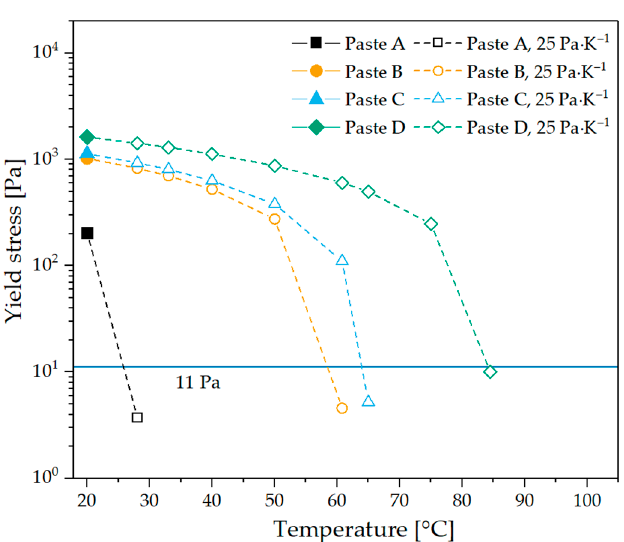
Figure A1. Yield stress versus temperature for pastes A–D. Values for temperatures >20 °C (open symbols) have been extrapolated assuming a linear decay with 25 Pa·K − 1 . The horizontal line at 11 Pa is the gravitational pressure imposed on the silver line during the PTP laser transfer process onto the substrate with a distance of 200 µm.